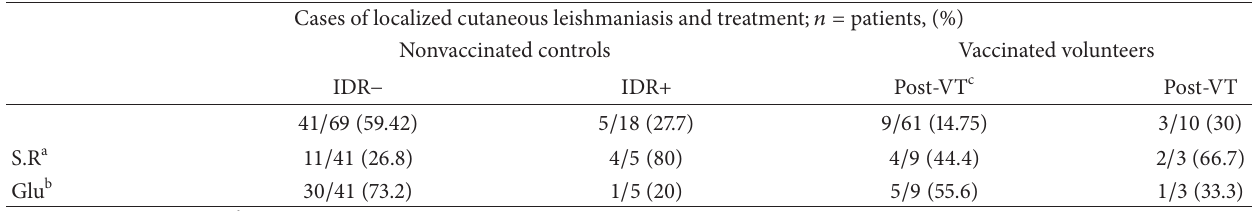
Table 6: Incidence of cutaneous leishmaniasis in IDR − and IDR+ nonvaccinated and vaccinated volunteers. Cases of localized cutaneous leishmaniasis and treatment; 𝑛 = patients, (%)